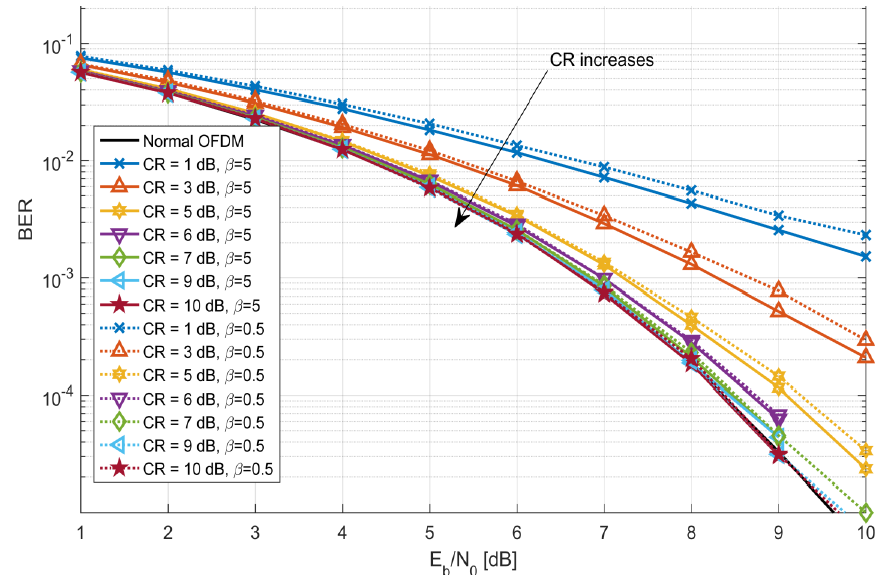
Figure 16. Bit Error Rate (BER) performance of the PC method with variable CR, N = 64, and the 4-QAM modulation over the Additive White Gaussian Noise (AWGN) channel.